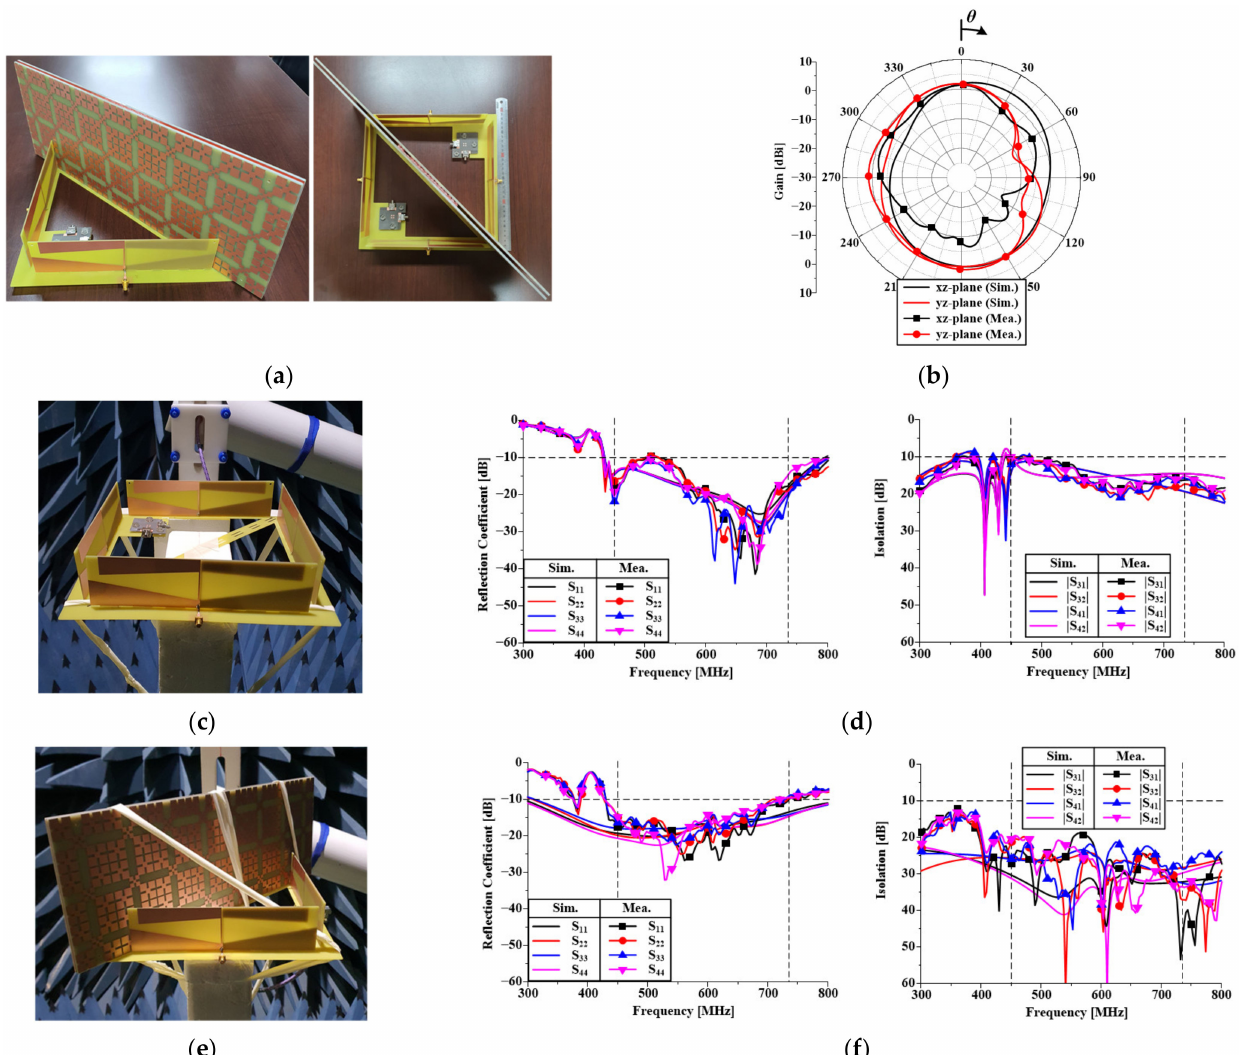
Figure 17. Fabricated antenna: ( a ) photographs of fabricated antenna, ( b ) simulated and measured radiation patterns at 580 MHz with absorber (when Port 1 is excited), ( c ) measurement setup of fabricated antenna without absorber, ( d ) simulated and measured performances (reflection coefficient, isolation) of the proposed antenna without absorber, ( e ) measurement setup of fabricated antenna with absorber, and ( f ) simulated and measured performances (reflection coefficient, isolation) of the proposed antenna with